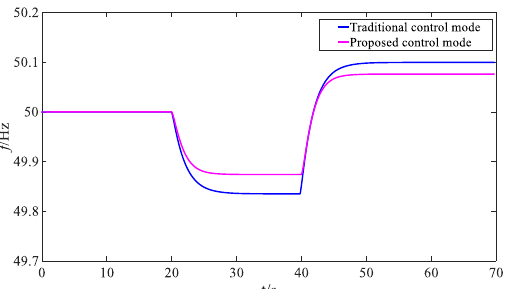
Figure 8. Frequency variation in different control modes under sudden load changes.